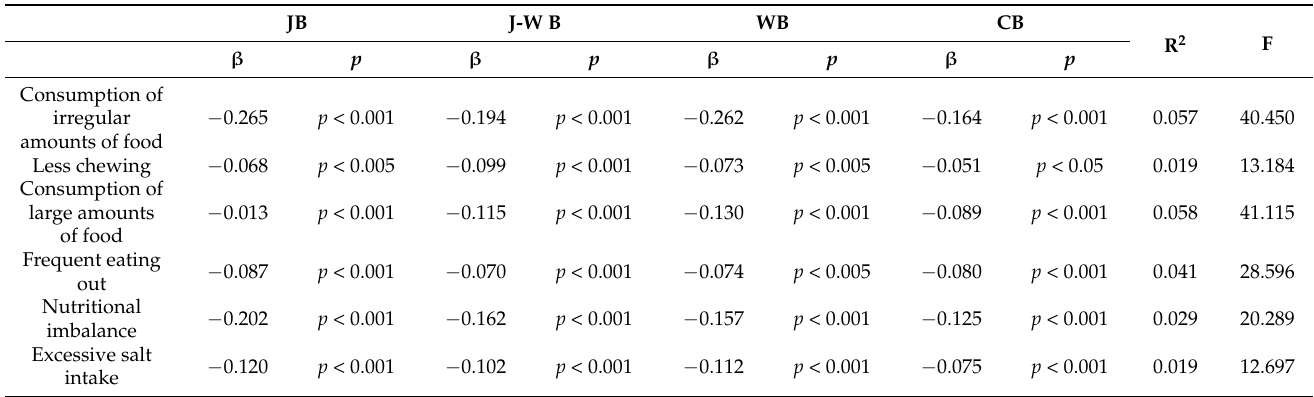
Table 3. Results of multiple regression analysis of the relationship between breakfast style and eating habits.